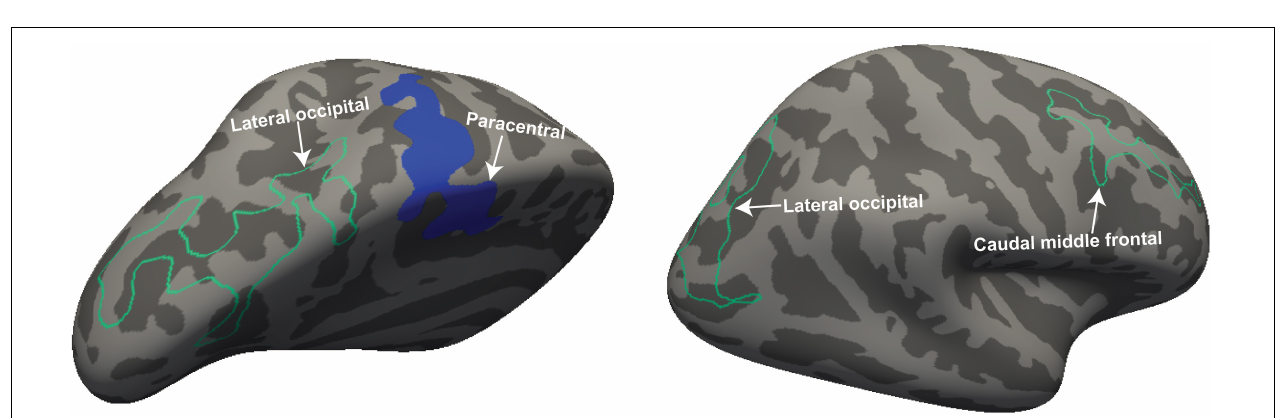
FIGURE 3 | For ME/CFS and HC, a significant cluster from interaction-with-group regressions with “HR.” The volume cluster of the paracentral gyrus was observed in the left hemisphere and the thickness cluster of lateral occipital and caudal middle frontal gyrus in both left and right hemispheres. The volume is represented with filled blue color whereas thickness is represented by unfilled green color. Significant volume and thickness clusters were overlaid on the inflated brain (left and right hemisphere) available in the FreeSurfer.